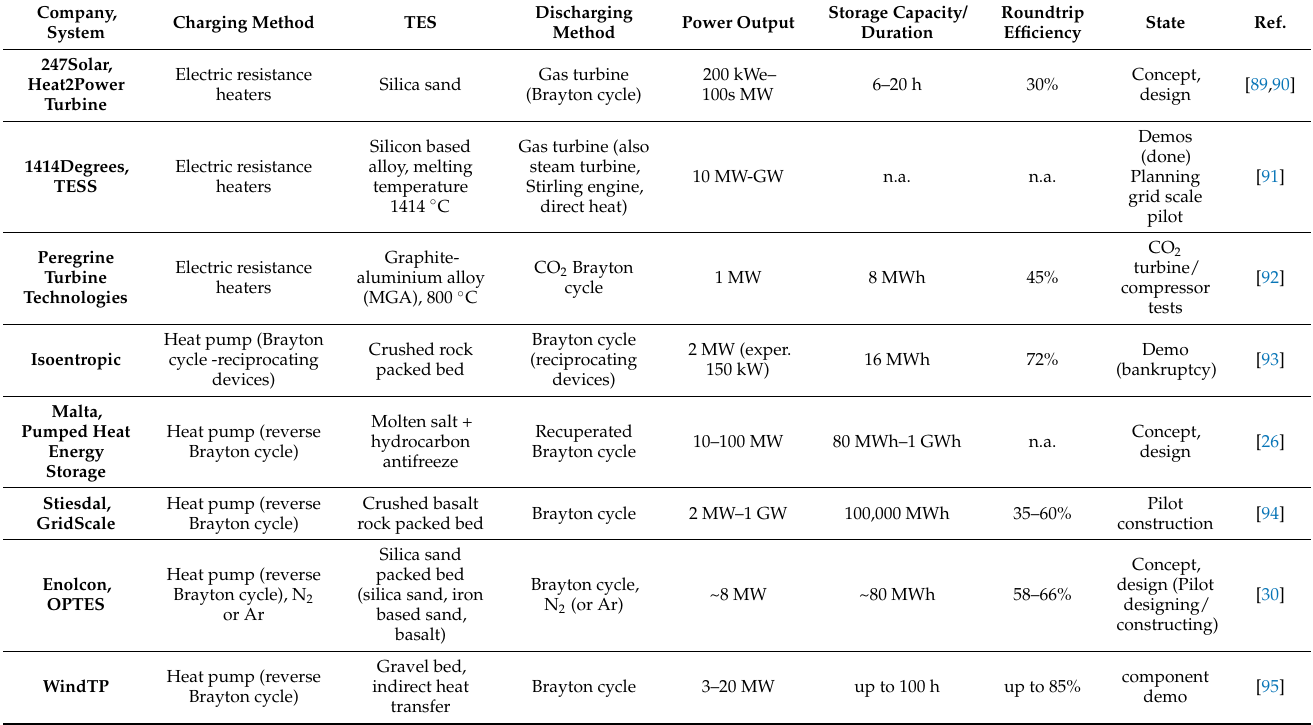
Table 2. List of commercial development projects in CB using Brayton cycle